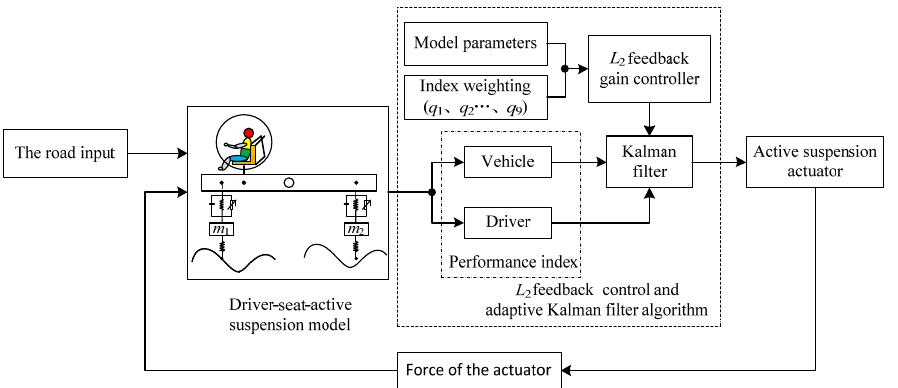
Figure 1. Schematic diagram of L 2 feedback Kalman filter algorithm for 9-DOF semi-vehicle model.